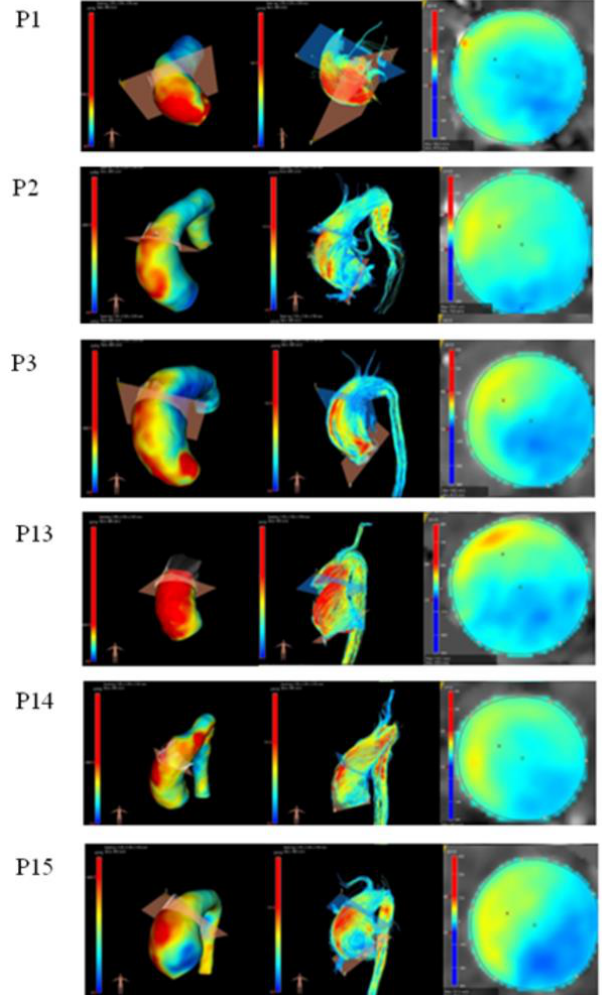
Figure 5. 4D flow analysis in patients with both molecular and haemodynamic data. First column: wall shear stress (WSS, range = 0 – 2000 mPA Ÿ s); second column: velocity streamlines (range = − 122–262 cm/s); third column: flow displacement.